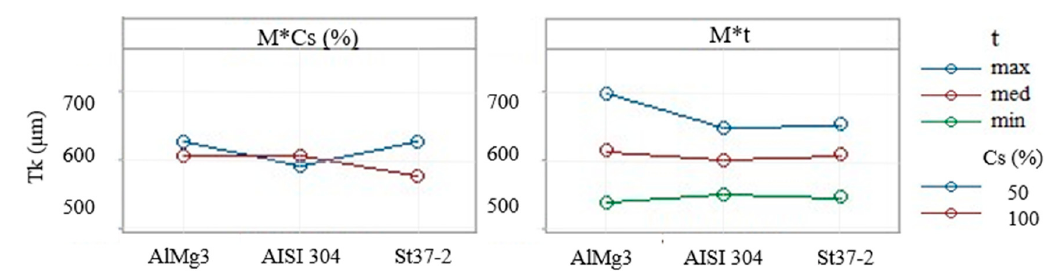
Figure 11. Main e ff ects plot for kerf section. Figure 11. Main effects plot for kerf section.